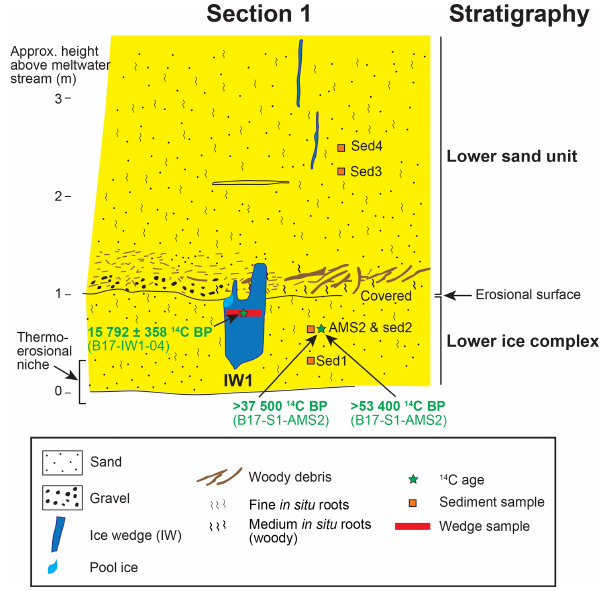
Figure 4. Schematic cryostratigraphic sketch of section 1, Batagay